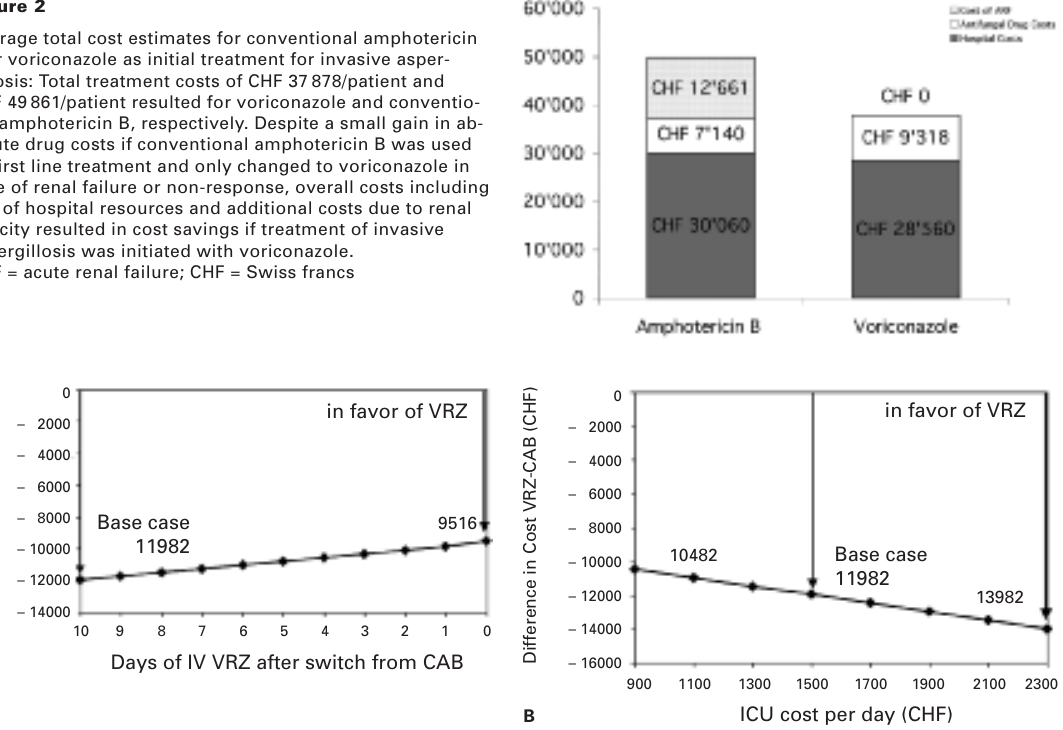
A. Sensitivity analysis depending on days of parenteral voriconazole application (IV) after switching from amphotericin B due to non-response or nephrotoxicity: Cost savings estimated for voriconazole over amphotericin B was reduced with early initiation of oral voriconazole treatment. VRZ = voriconazole, CAB = conventional amphotericin B; CHF = Swiss francs B. Sensitivity of costs due to different intensive care unit (ICU) cost per day: Independent on the cost assumptions for the stay on the ICU, voriconazole treatment remained cost-effective even in case daily ICU cost estimates were equalised to the normal cost estimates on the medical ward (CHF 900/day). VRZ = voriconazole, CAB = conventional amphotericin B; CHF = Swiss francs